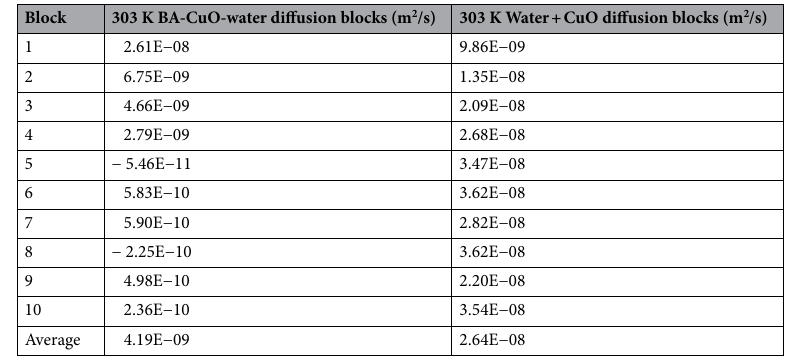
Table 4. Diffusion rates calculated for different segments of simulation and then average was taken. Second column holds the diffusion rate for BA modified CuO-water system. Third column holds the diffusion rate for CuO-water system.